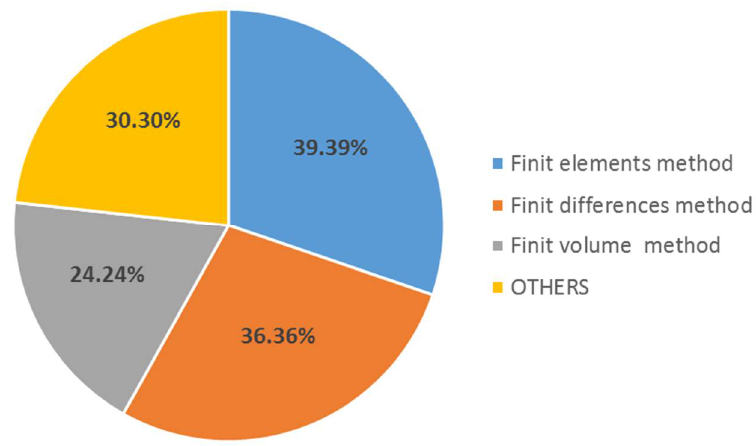
Figure 12. Different numerical methods in the thermal domain.